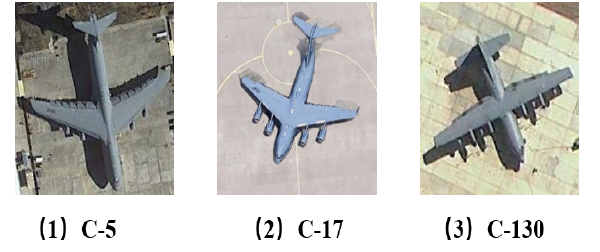
Figure 1. Three kinds of transport aircraft: ( 1 ) C-5, ( 2 ) C-17 and ( 3 )